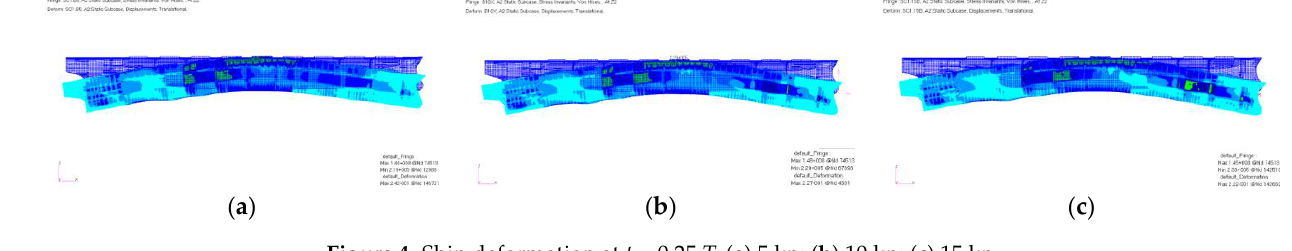
Figure 4. Ship deformation at t = 0.25 T. ( a ) 5 kn; ( b ) 10 kn; ( c ) 15 kn.